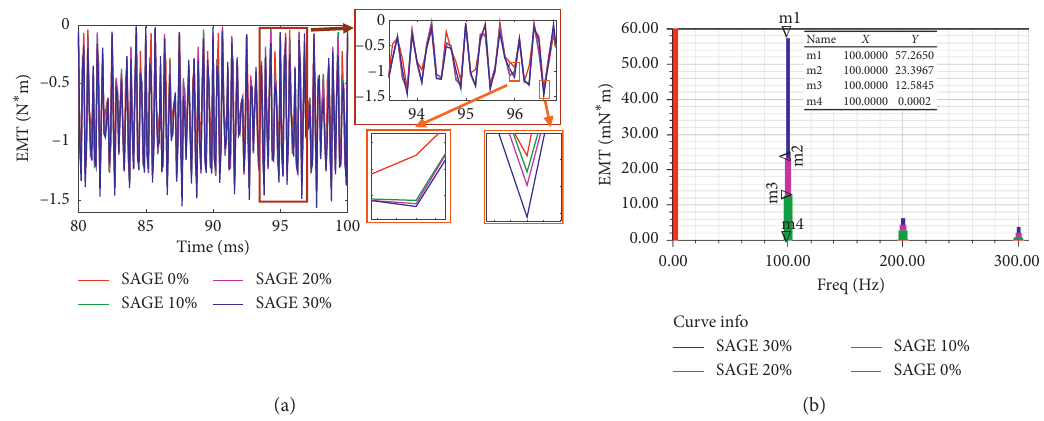
Figure 6: EMT before and after SAGE by FEA: (a) time-domain waveforms and (b) EMT spectra.